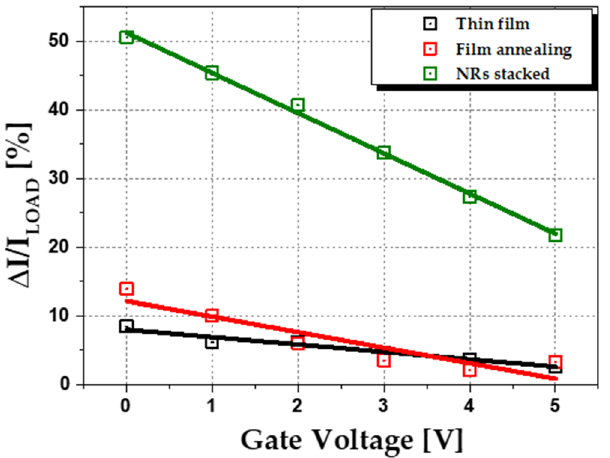
Figure 8. Pressure test result on the manufactured TFT pressure sensor. A solid is unloading condition and an open is the loading condition of the corresponding gate voltage; ( a ) Thin film type; ( b ) Film annealing type; ( c ) NRs stacked type.